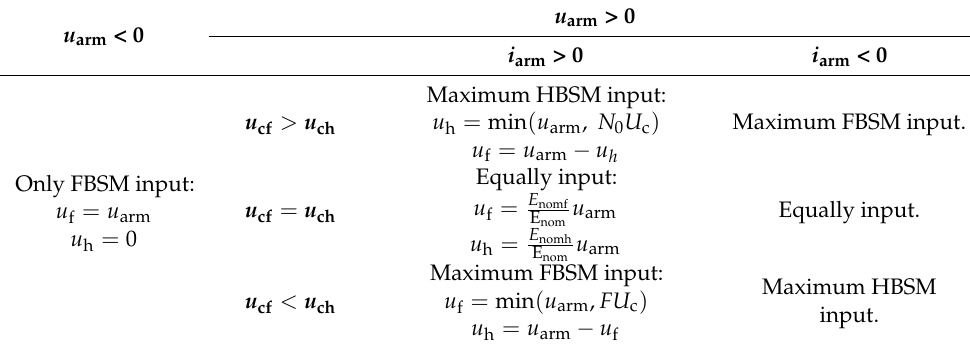
Table 1. Relation between arm voltages of FBSMs and